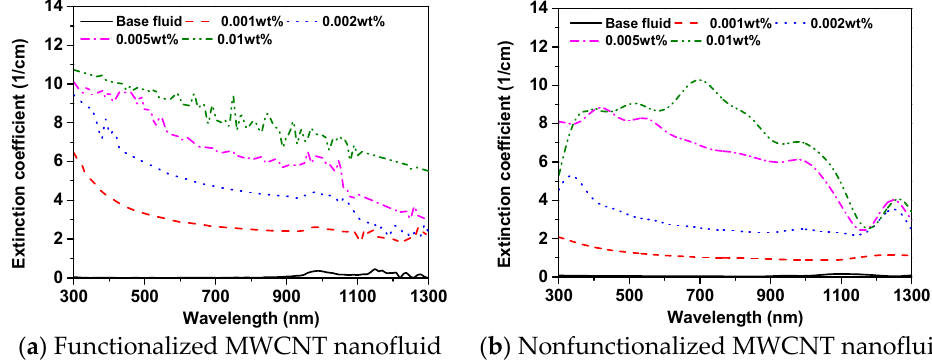
Figure 7. Extinction coefficient of ( a ) functionalized and ( b ) nonfunctionalized MWCNT nanofluid.